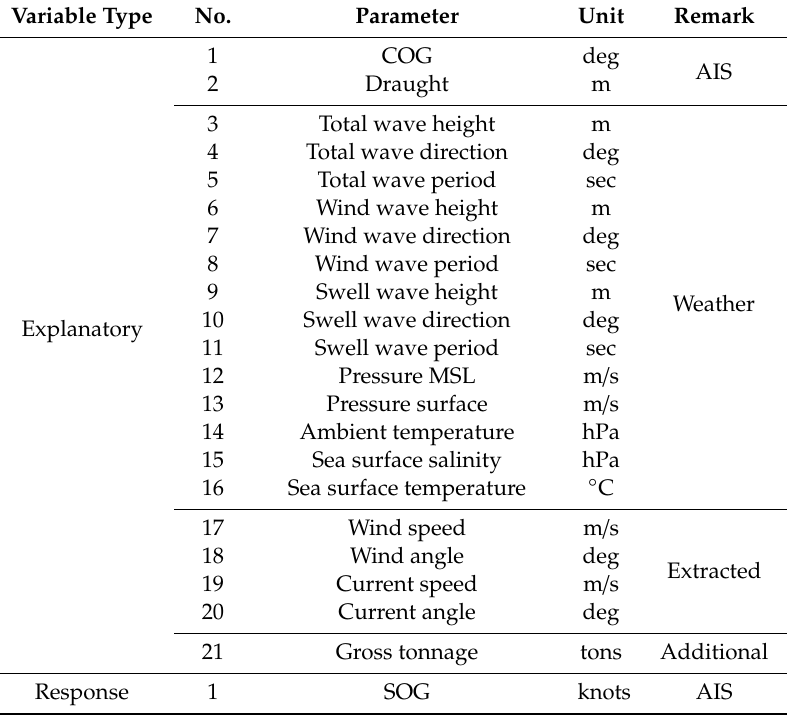
Table 6. List of candidate explanatory